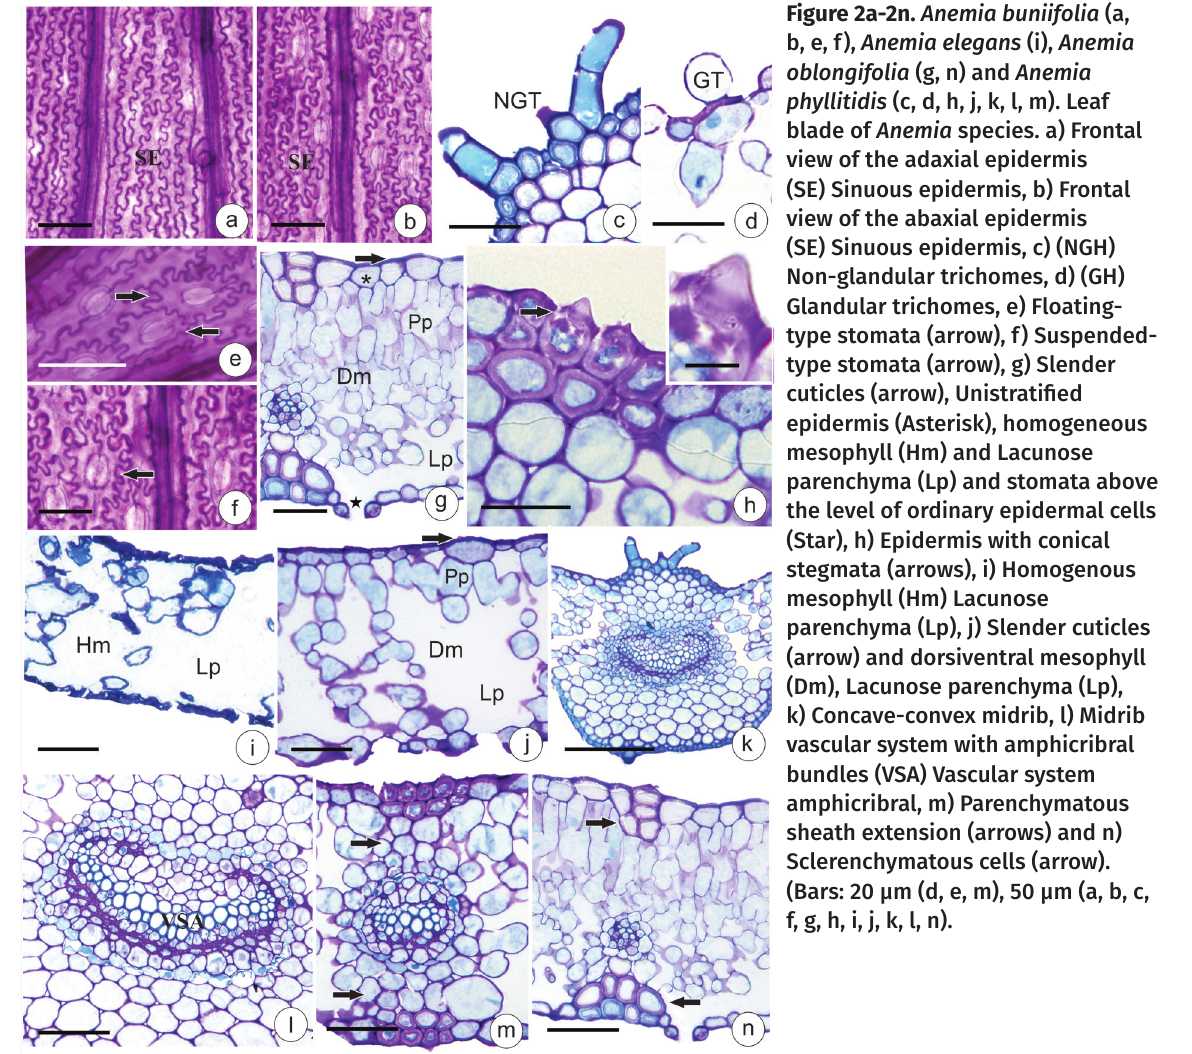
Figure 2a-2n. Anemia buniifolia (a, b, e, f), Anemia elegans (i), Anemia oblongifolia (g, n) and Anemia phyllitidis (c, d, h, j, k, l, m). Leaf blade of Anemia species. a) Frontal view of the adaxial epidermis (SE) Sinuous epidermis, b)